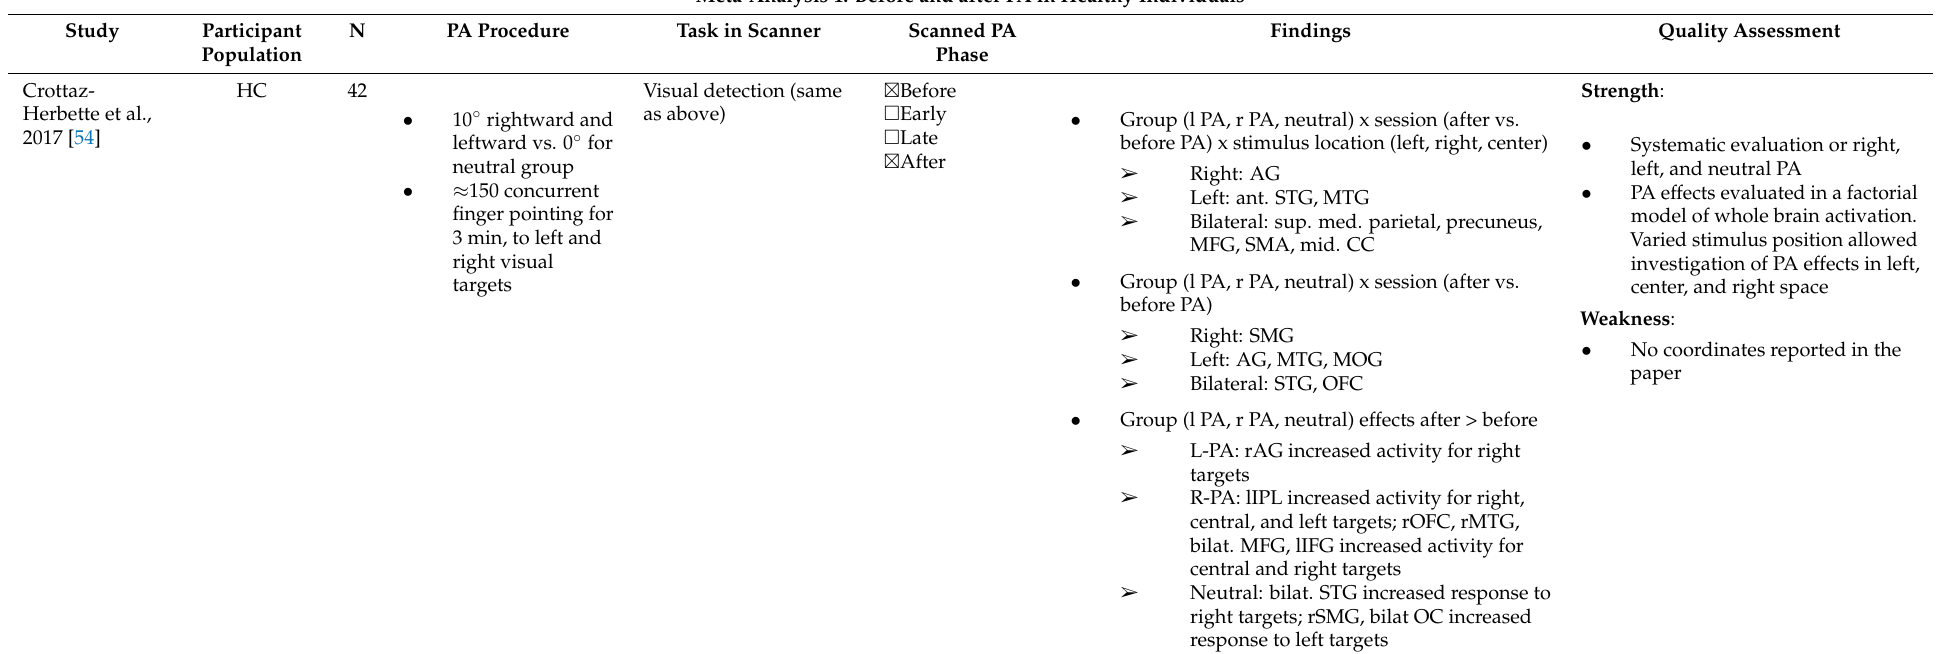
Meta-Analysis 1: Before and after PA in Healthy